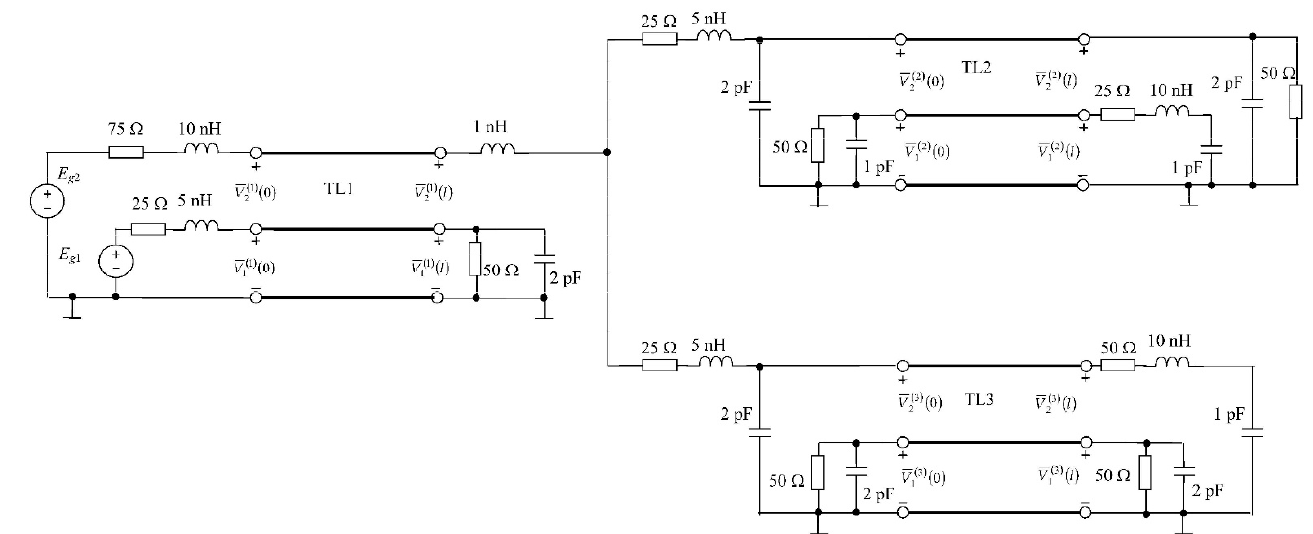
Figure 6. Circuit including three distributed parameter multiconductor transmission lines (DPMTLs).